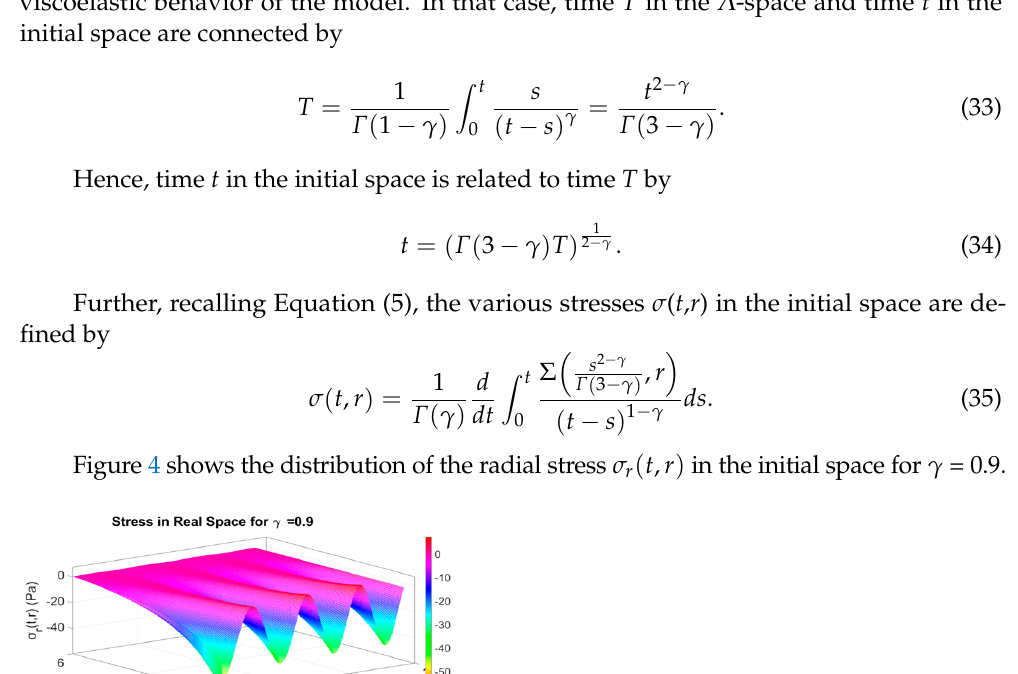
Figure 5. Distribution of the stress 𝜎 (cid:3087) (𝑡,𝑟) in the initial space for γ = 0.9.